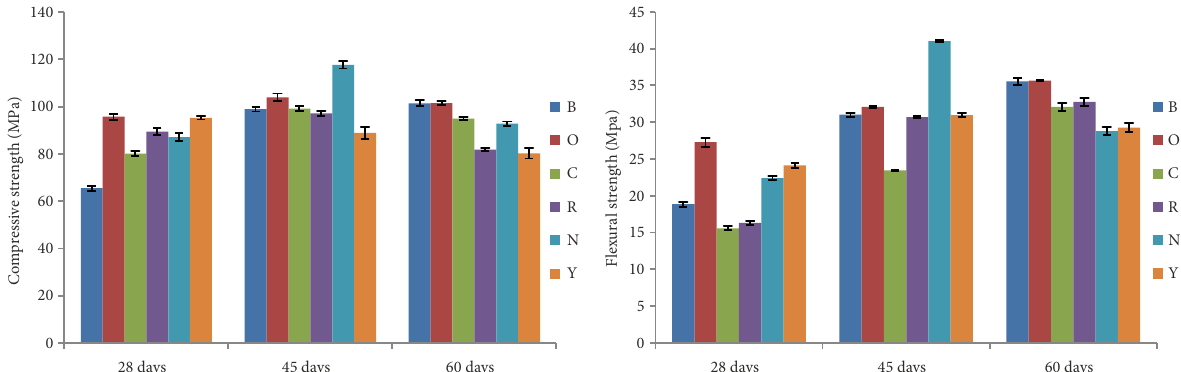
Fig. 3. Compressive strength test at 28, 45 and 60 days Fig. 4. Flexural strength test at 28, 45 and 60